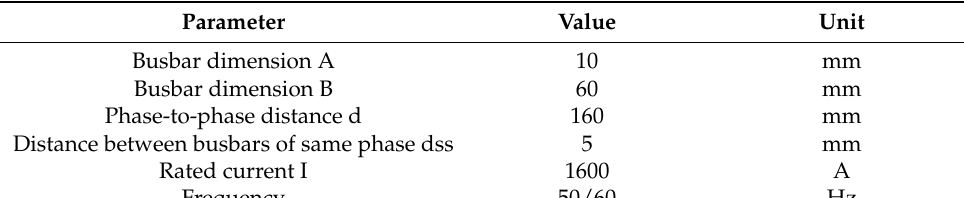
Table 6. Simulation properties for double busbar system.